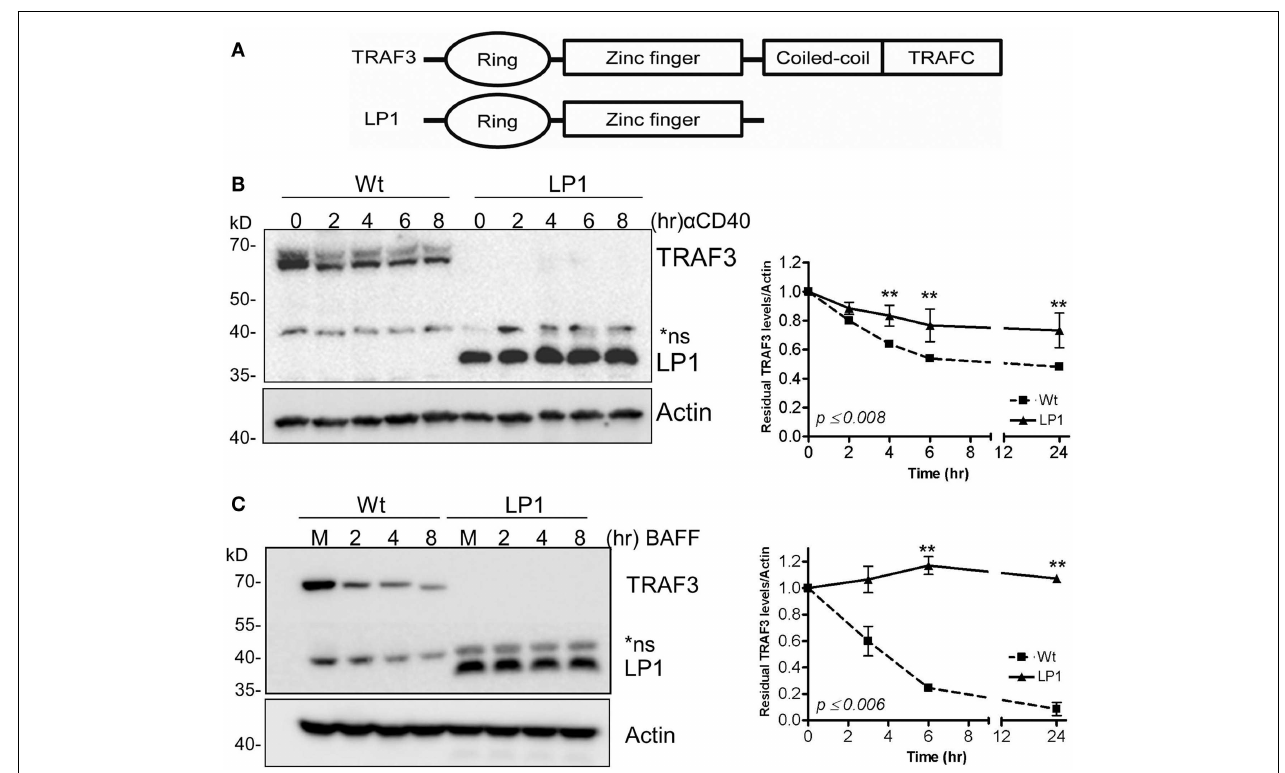
200ng/ml of recombinant BAFF (C) for the indicated times at 37°C.Whole cell lysates were resolved by SDS-PAGE andWestern blots of gel probed with anti-FLAG Ab to assess relative cellular levels ofWt and LP1TRAF3. Graphs depict mean values ± SEM ofTRAF3 band intensities, normalized to actin, from immunoblots of three experiments. **Statistically significant differences betweenWt and LP1TRAF3, analyzed as in Section “Materials and Methods.” Numbers on the graph indicate the highest p values for individual time